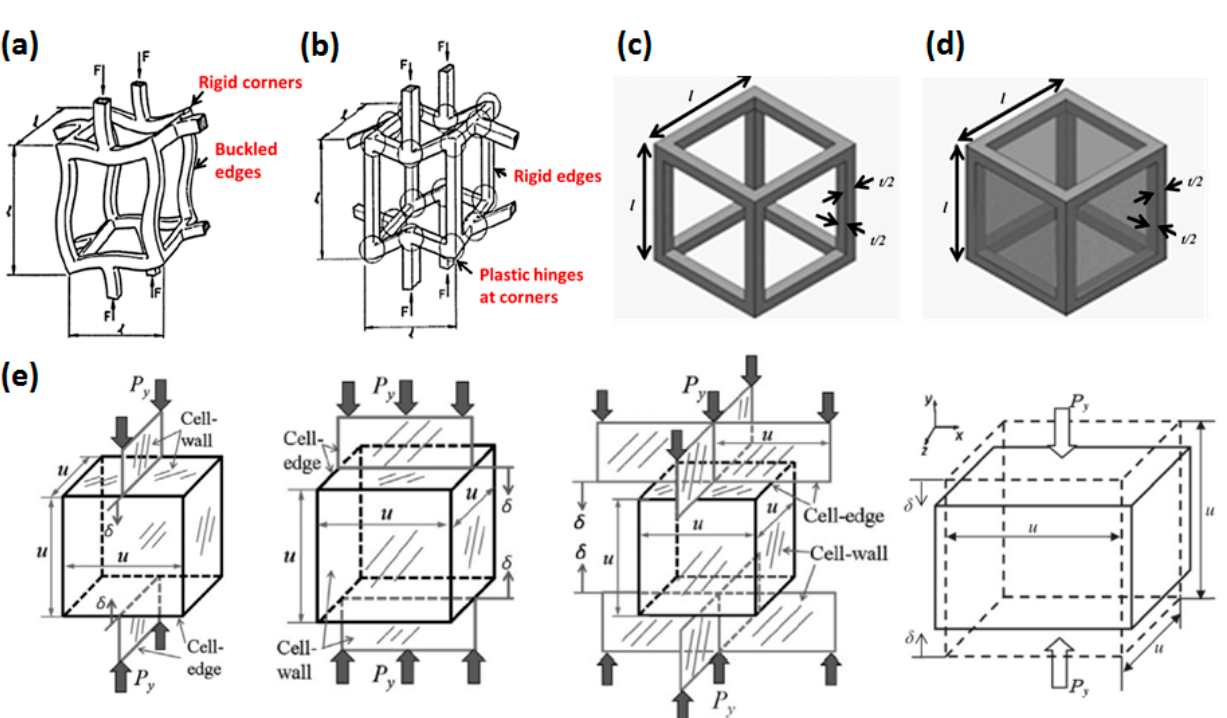
Figure 5. Deformation mechanism ( a ) elastic collapse and ( b ) plastic collapse [28], and single cell model ( c ) open-cell unit [109], ( d ) closed-cell unit [110], and ( e ) cell model under different uniaxial loadings [111].